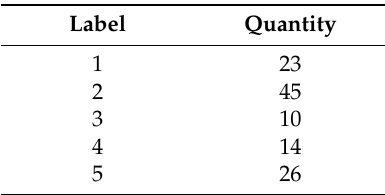
Table 2. The states arrangement of IEC TC